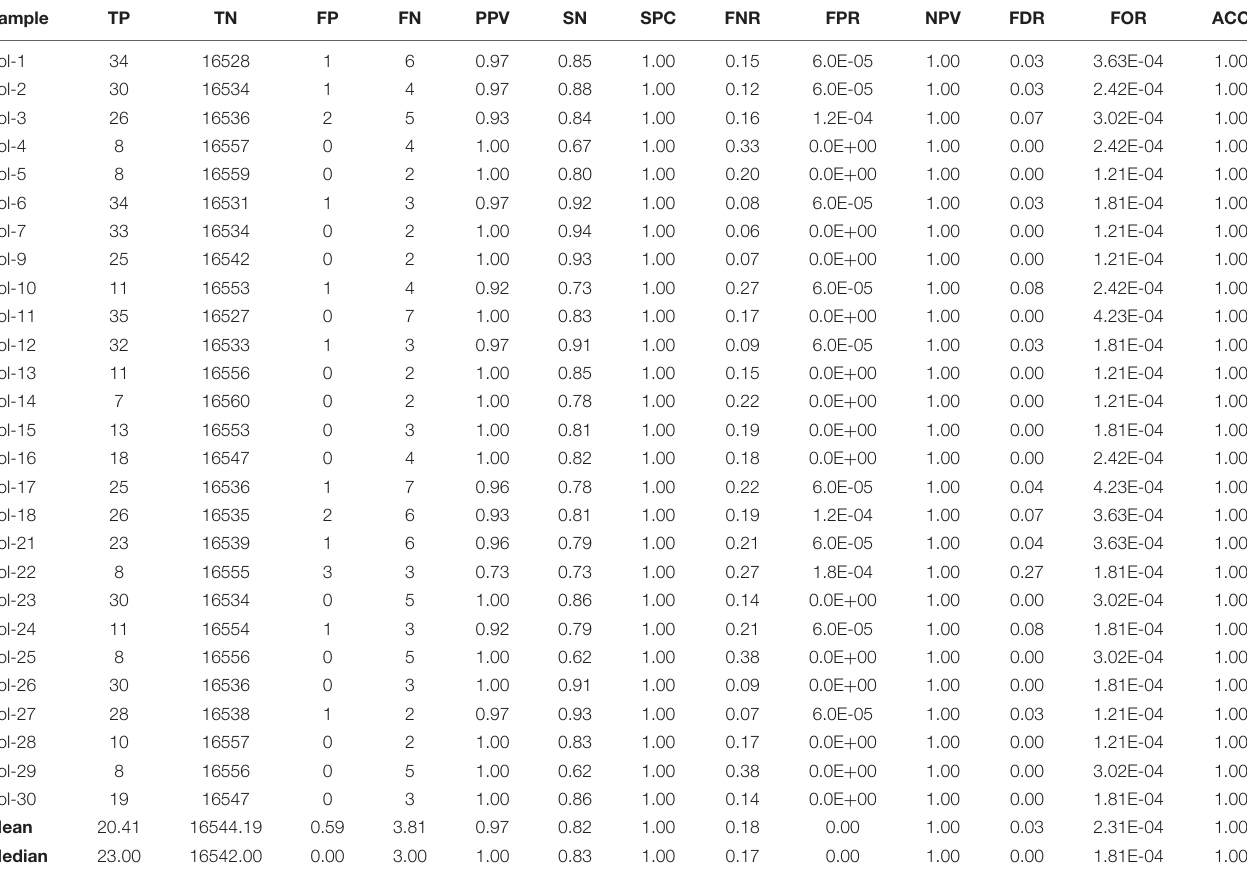
TABLE 3 | Basic statistics for Mutect2 variants in Polizzello ancient